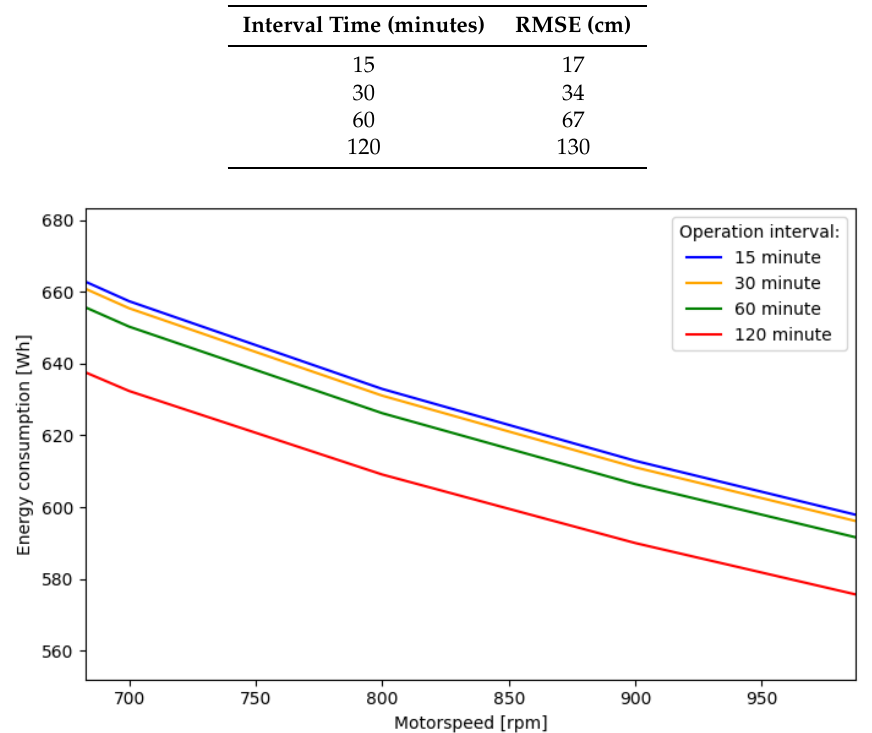
Table 3. RMSE between compensator position and sea level for different control strategies.